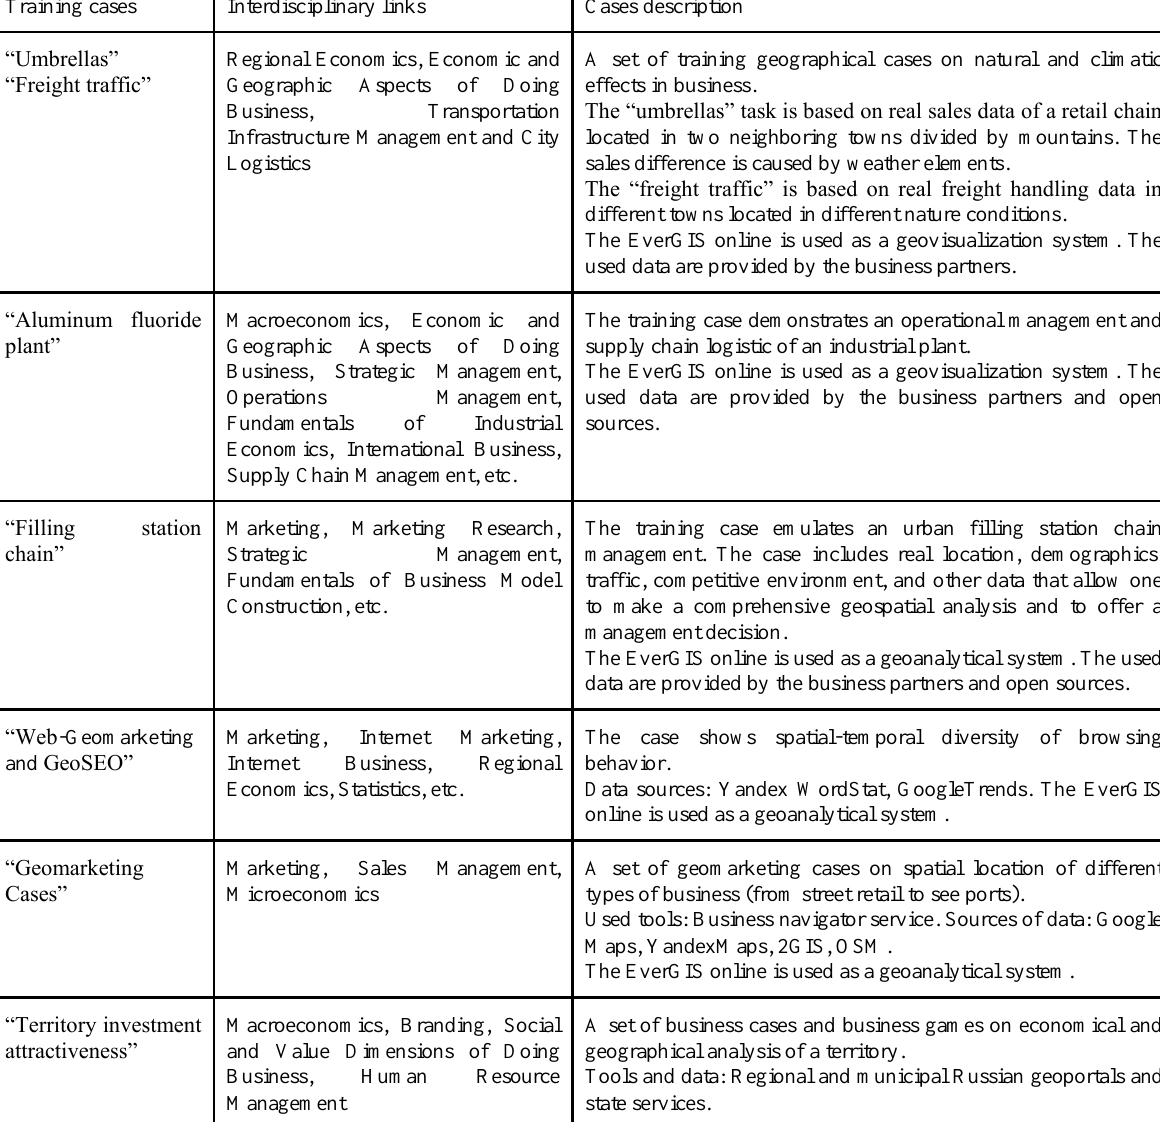
Table 1. The training cases